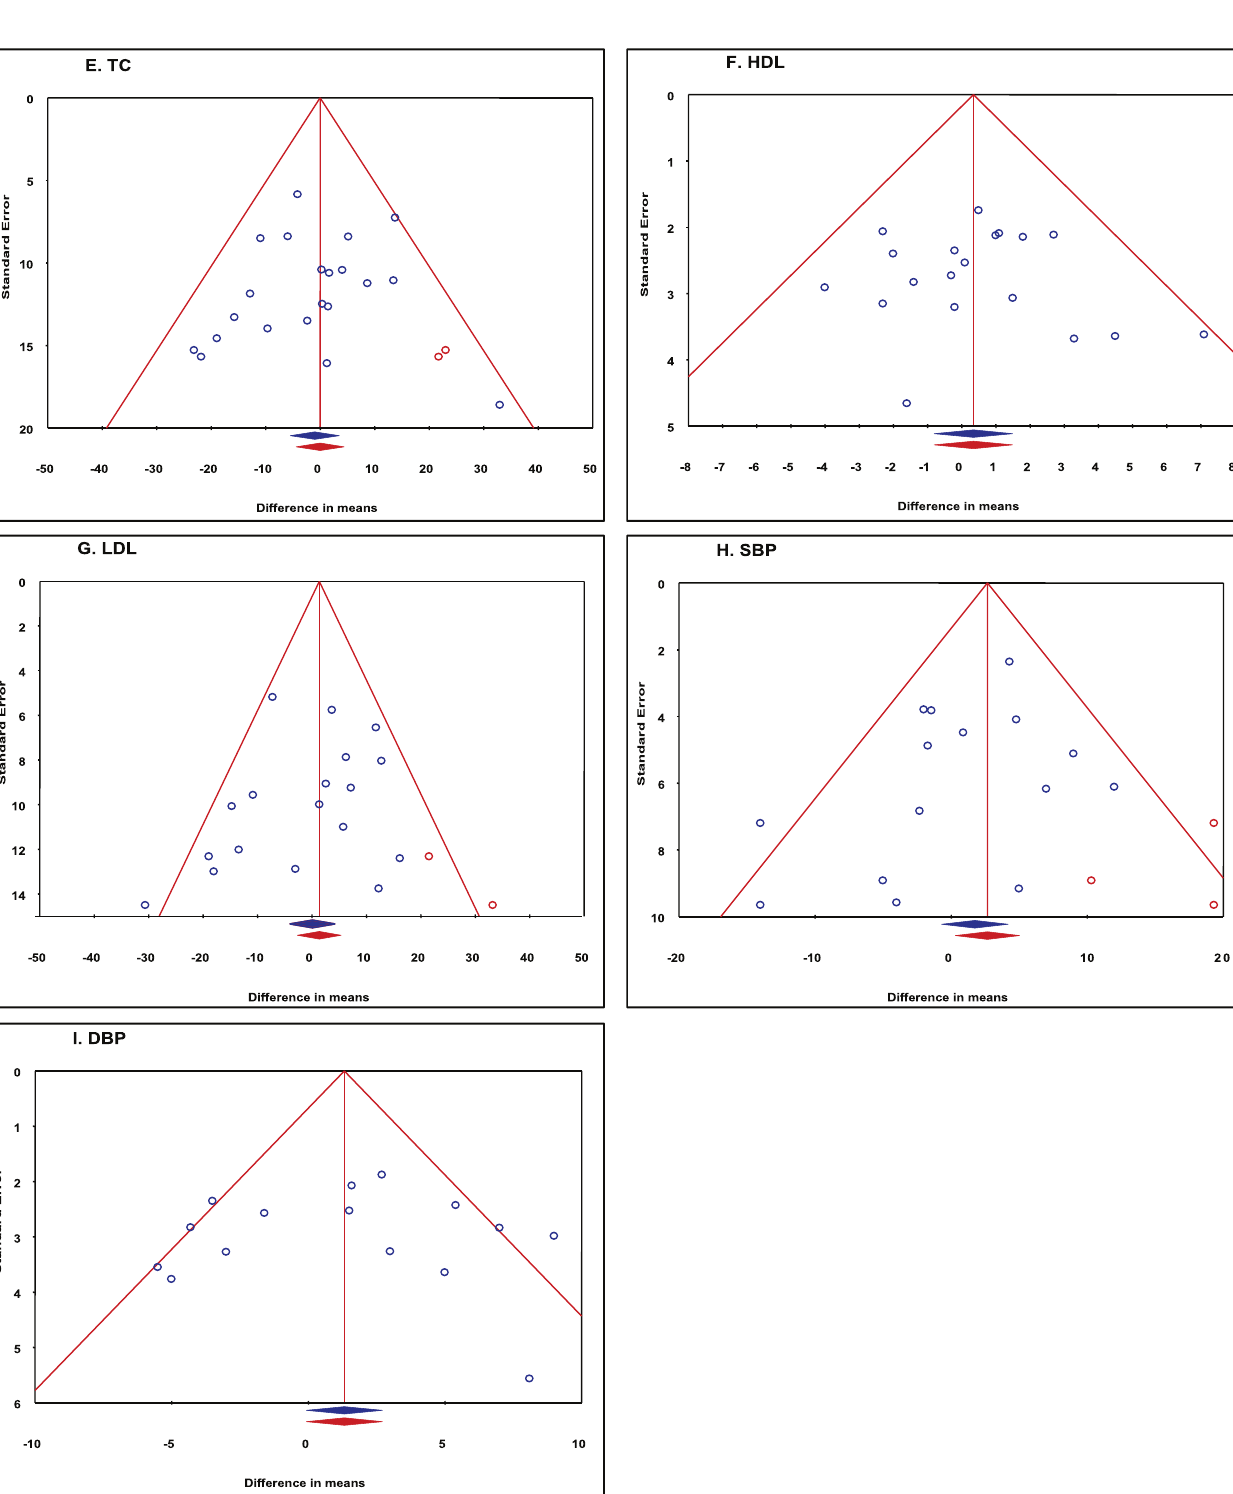
FIGURE 6 (cont.) - Funnel plots of standard error by difference in means (publication bias tests) of the effects of I. paraguariensis consumption on the outcomes of this meta-analysis. BMI – body mass index; DBP – diastolic blood pressure; HDL – HDL- cholesterol; LDL – LDL-cholesterol; SBP – systolic blood pressure; TC – total cholesterol; TG –